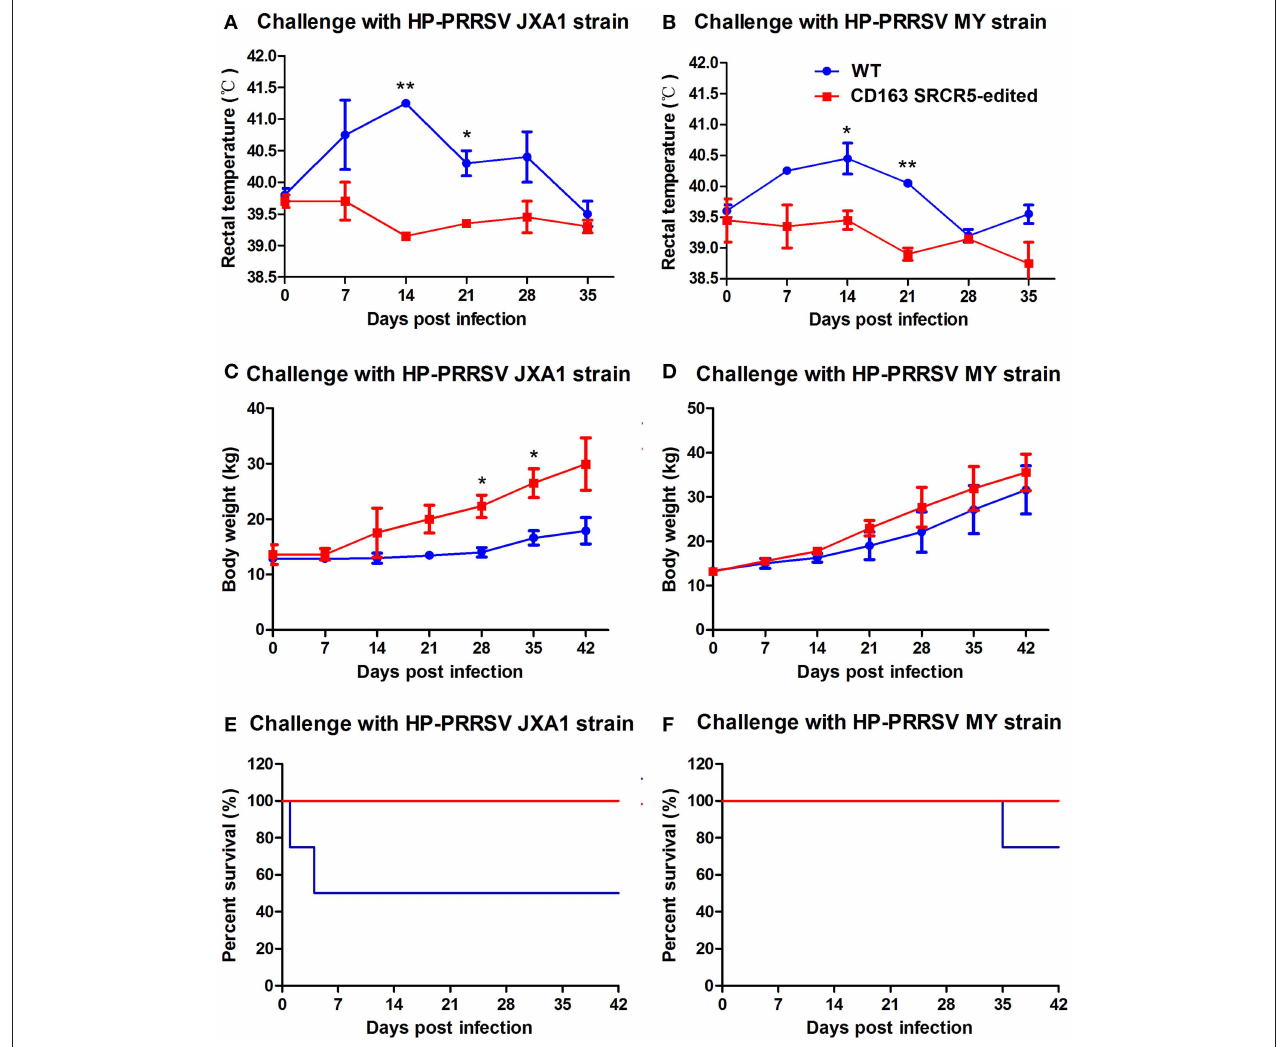
FIGURE 5 | CD163 SRCR5-edited pigs survive post PRRSV challenge. (A–F) Rectal temperature (A,B) and body weights (C,D) were measured on day 0 prior to challenge and the days 7, 14, 21, 28, 35, 42 post-challenge with PRRSV JXA1 and MY strains. (E,F) The mortality and survival curve of piglets during PRRSV JXA1 (E) and MY (F) strain challenges. The red line represents CD163 SRCR5-edited pigs, and the blue line represents WT controls. Data are representative of the results of three independent experiments (means ± SE). Significant differences are indicated as follows: * P < 0.05, ** P <